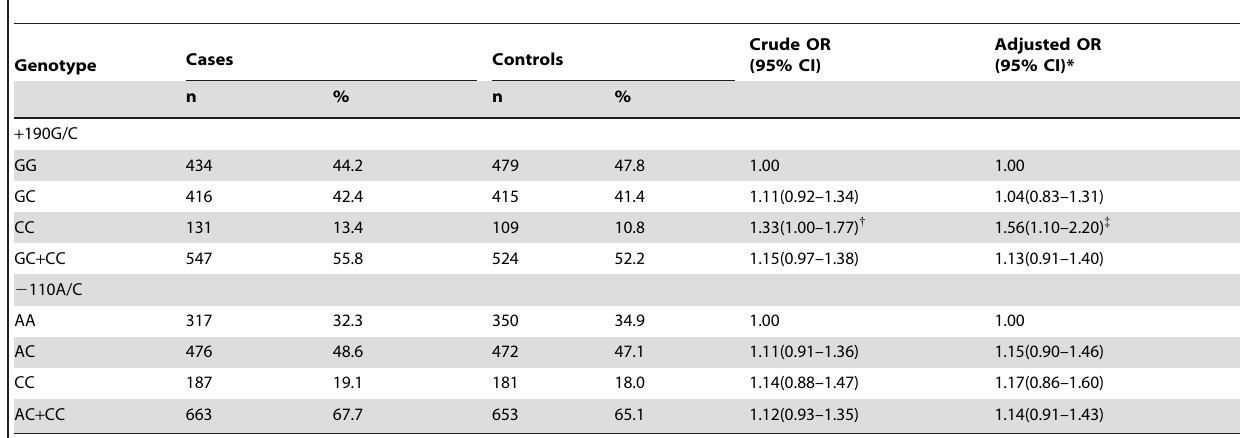
Table 2. Analysis of Association between HSPA1A Polymorphisms and Risk of CHD in a Chinese population.